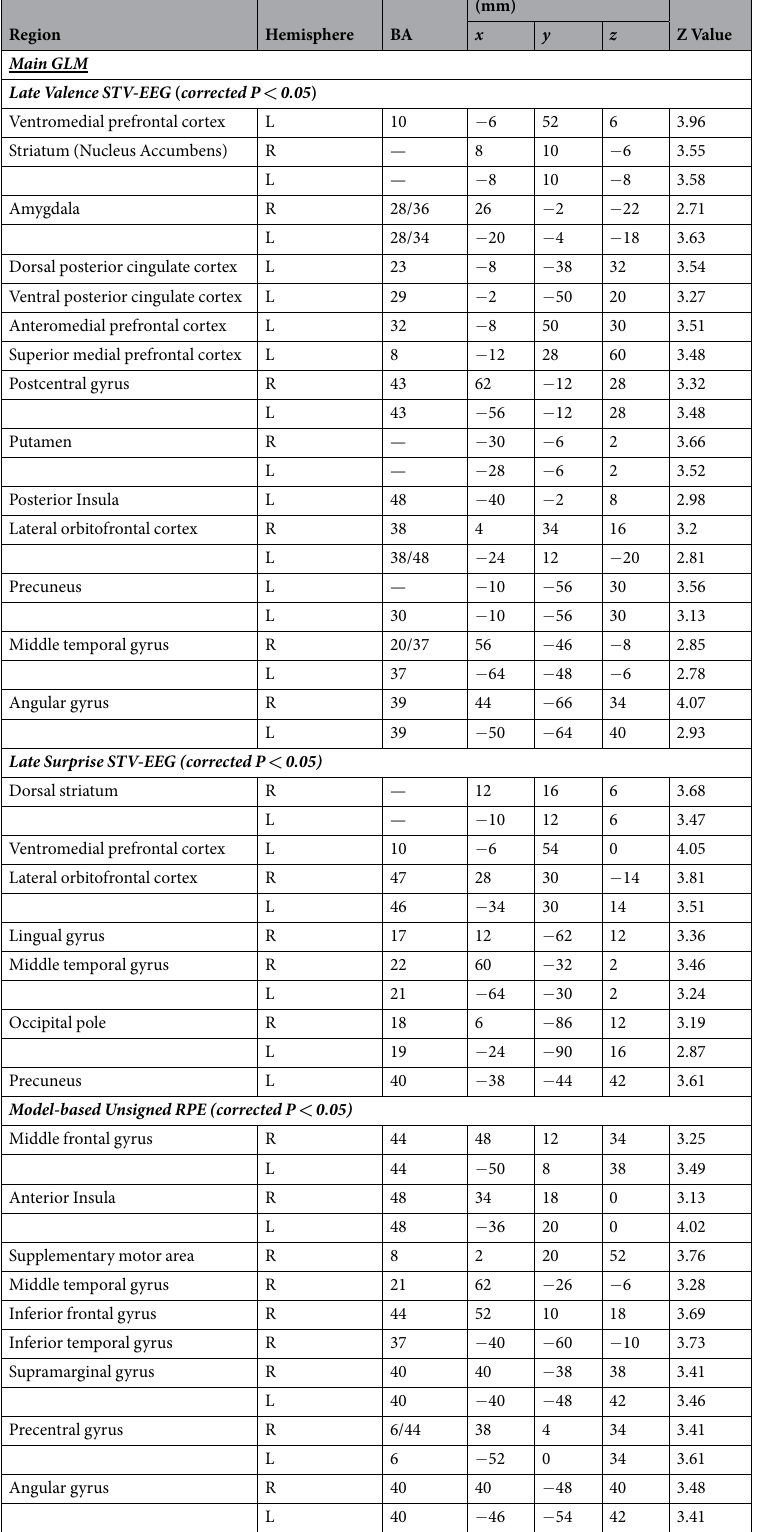
Table 1. Model-based and EEG-informed fMRI analyses. Complete list of activations correlating with the single-trial variability in the model-based unsigned RPE and the EEG-derived Late Valence and Surprise regressors (GLM 1; mixed effects, |Z| > 2.57, cluster-corrected for multiple comparisons). MNI, Montreal Neurological Institute; L, left hemisphere; R, right hemisphere, BA, Broadmann